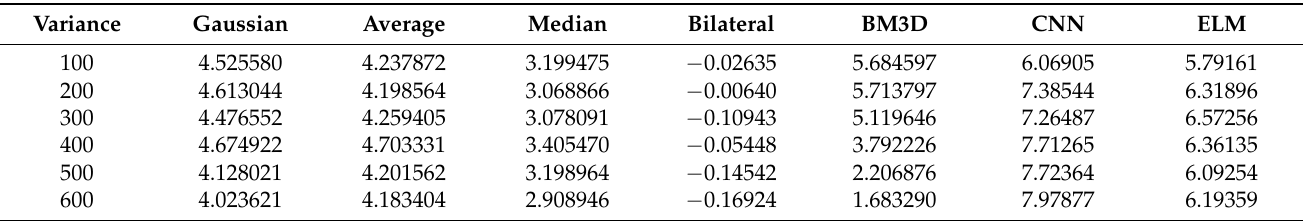
Table 1. Comparison of improved SNR with respect to the variance for various denoising modalities (here we keep input and output size as 50 × 50).